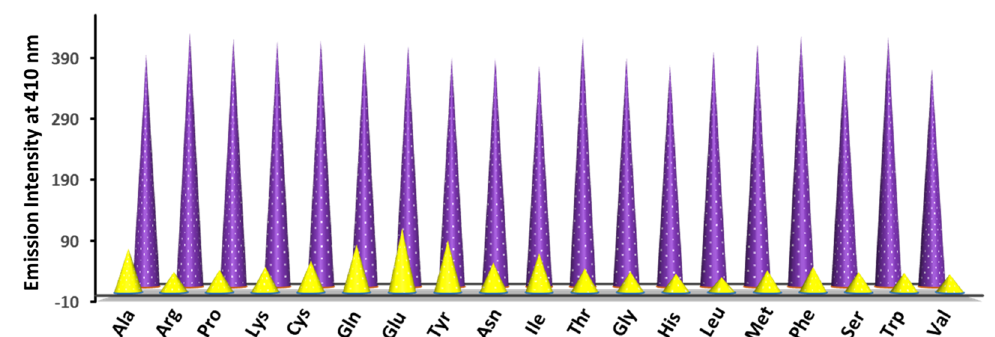
Figure 13. Selectivity of chemosensor L1 towards Asp in the presence of other amino acids: L1 + amino acids (yellow cones) and L1 + amino acids + Asp (purple cones). All studies were conducted in EtOH.